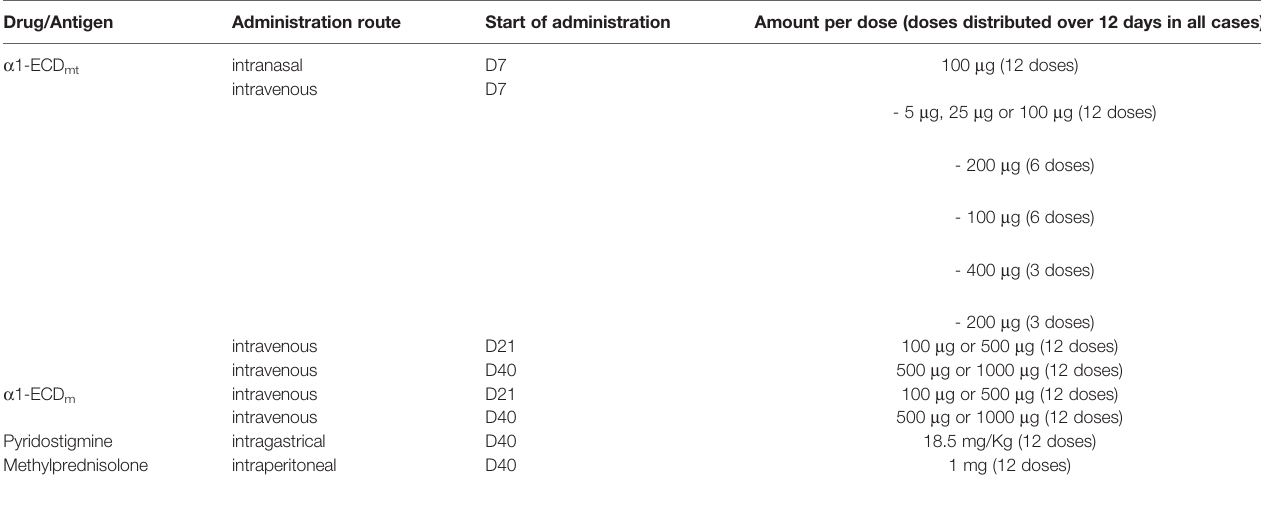
TABLE 1 | Overview of the different treatment regimens